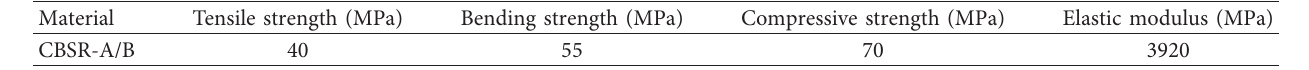
Table 3: Mechanical properties of epoxy resin.